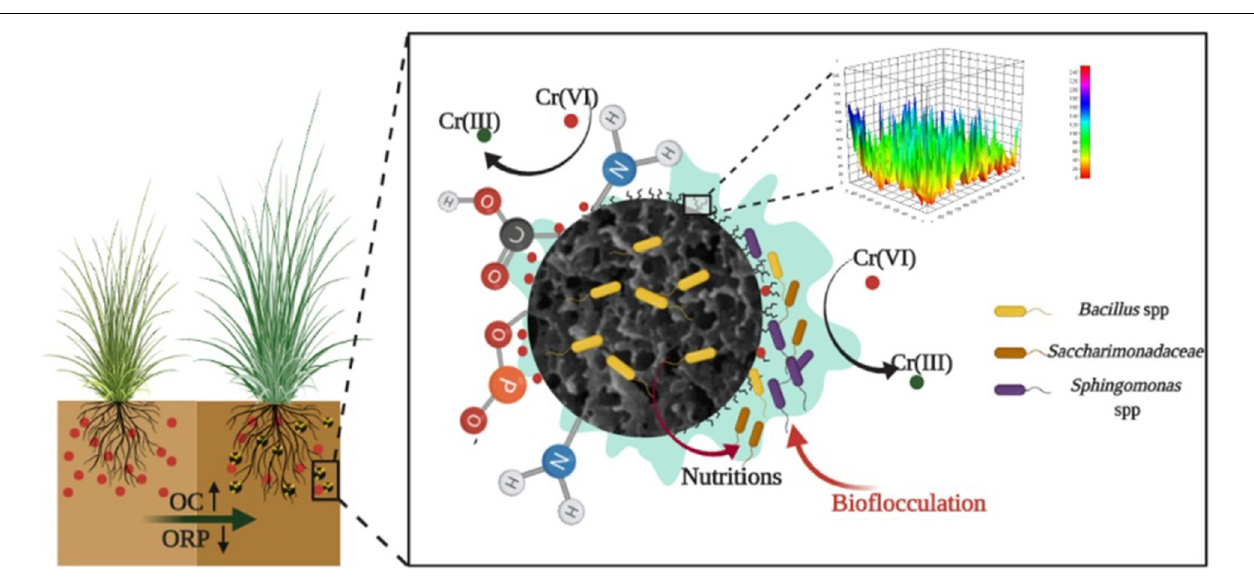
FIGURE 6 | Remediation mechanism of biochar-based Cr-reducing bacteria on Cr-contaminated soil